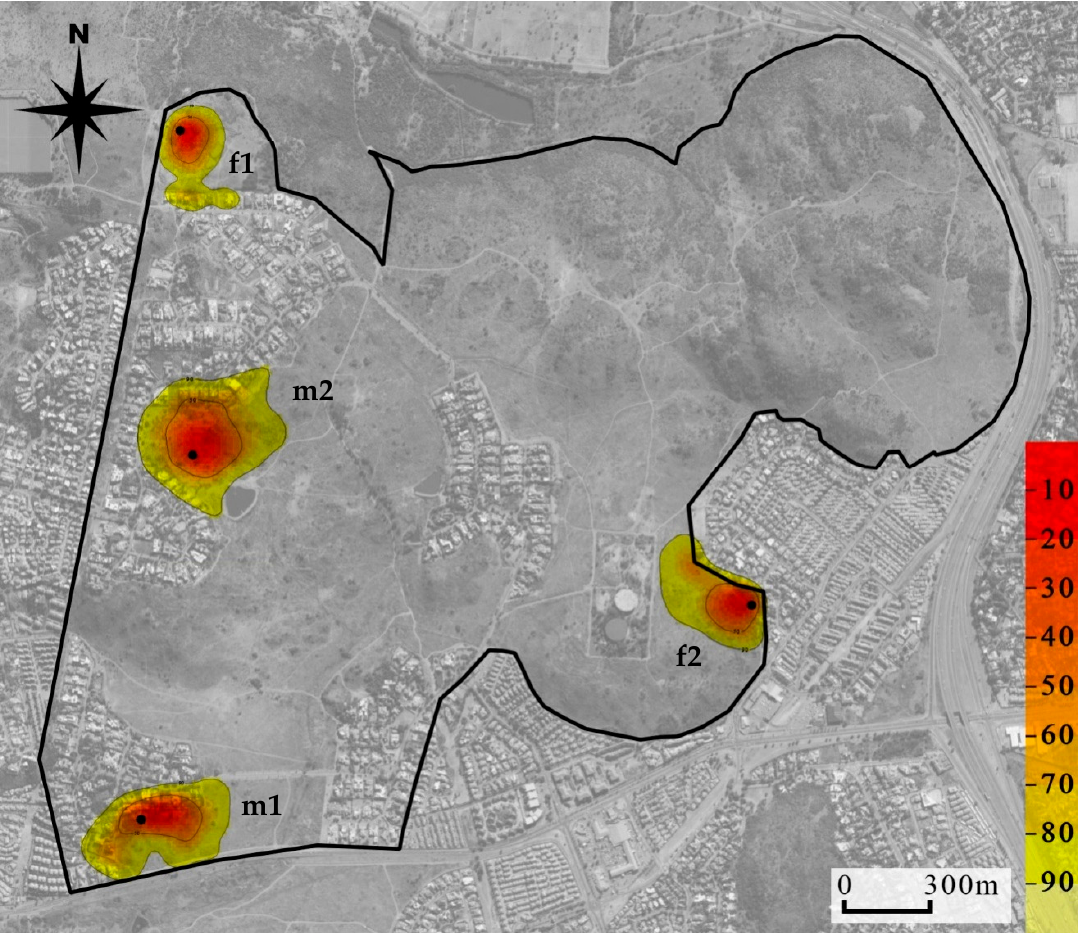
Figure 3. Location utilization density (by the kernel method) of four yellow mongooses overlaid on an aerial photograph of the Meyersdal estate. More red shows core use areas, while the more yellow shows wider area of use and extends to the 95% home range use; black dots indicate den location.